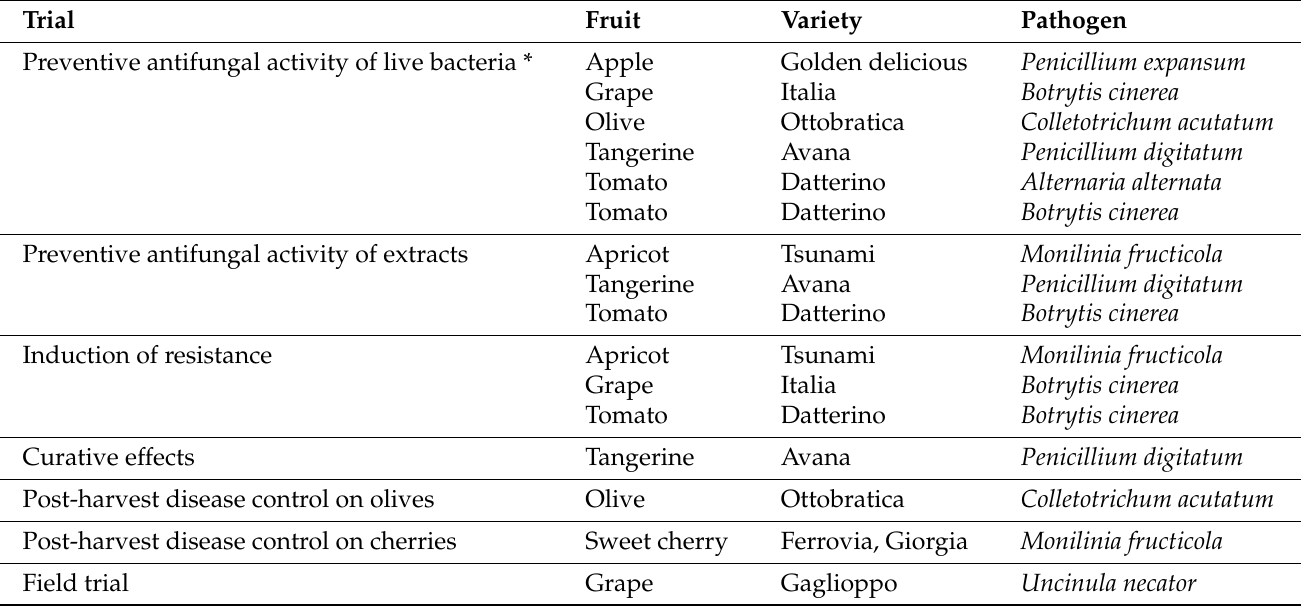
Figure 1. Workflow used in this study. ( A ) A microbial wash from environmental samples was mixed with a solution containing a high density of spores of Penicillium digitatum . ( B ) Isolates were screened for their efficacy using a wide set of in vitro and in vivo trials and ( C ) identified as Pseudomonas spp. by sequencing a portion of the 16S rRNA gene. From the most promising bacterial isolates, we produced a set of alcoholic extracts ( D ) that were then tested ( E ) for their efficacy in vivo and in setups simulating real-world applications, and ( F ) using an untargeted metabolomics approach, we attempted an annotation of the molecules likely to have antifungal activity. Created with BioRender.com. Table 1. Summary of the host–pathogen combinations used for each trial. Tests were performed using alcoholic extracts from bacterial cultures, except the experiment marked with “*”, where we used live bacterial